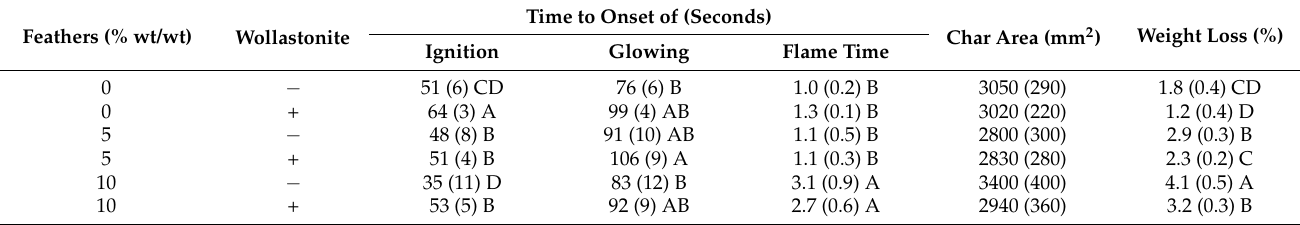
a Values represent means of five replicates per treatment while figures in parentheses represent one standard deviation. Values followed by the same letter(s) do not differ significantly from each other by a Duncan’s multiple range test ( α ’ = 0.05). Char area values did not differ significantly from each